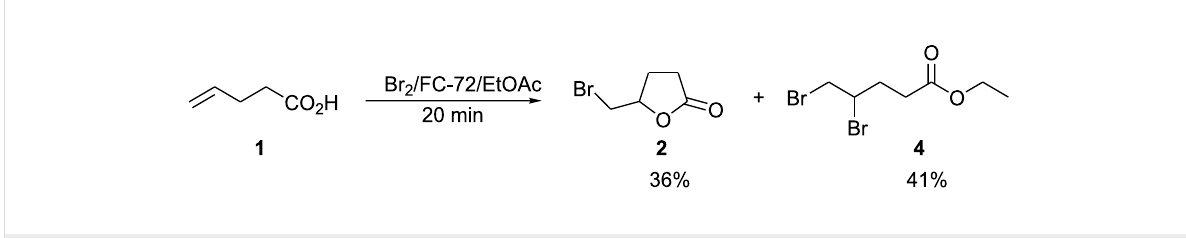
Scheme 2: Bromolactonization of 4-pentenoic acid in ethyl acetate.